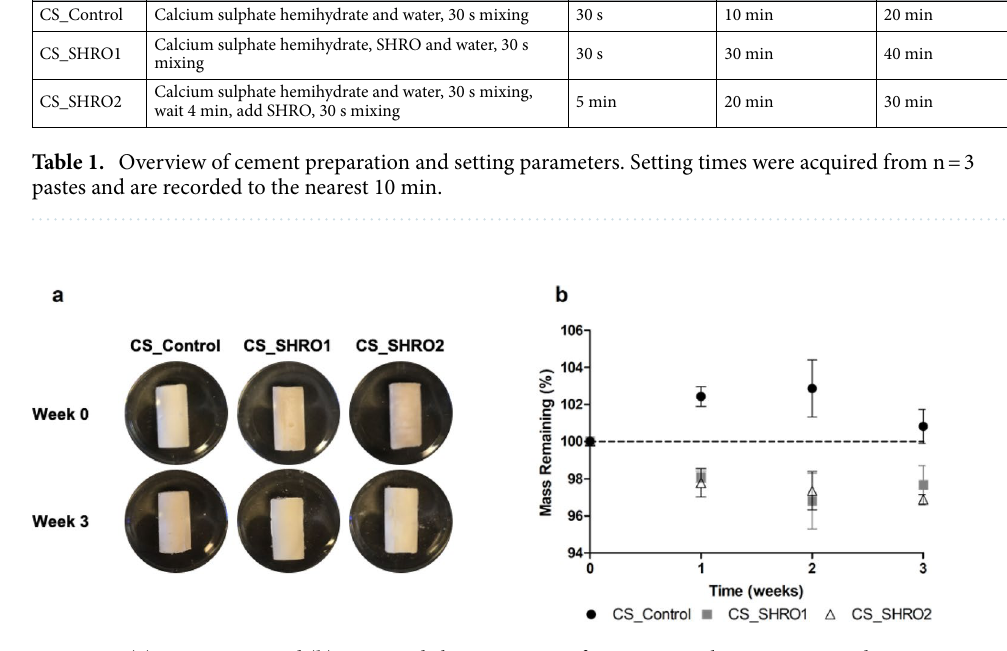
Figure 1. ( a ) Appearance and ( b ) measured changes in mass for CS_Control, CS_SHRO1 and CS_SHRO2 cements as prepared (Week 0) and following 3 weeks of static ageing in distilled water (Week 3) (mean ± SD, n = 3) (GraphPad Prism